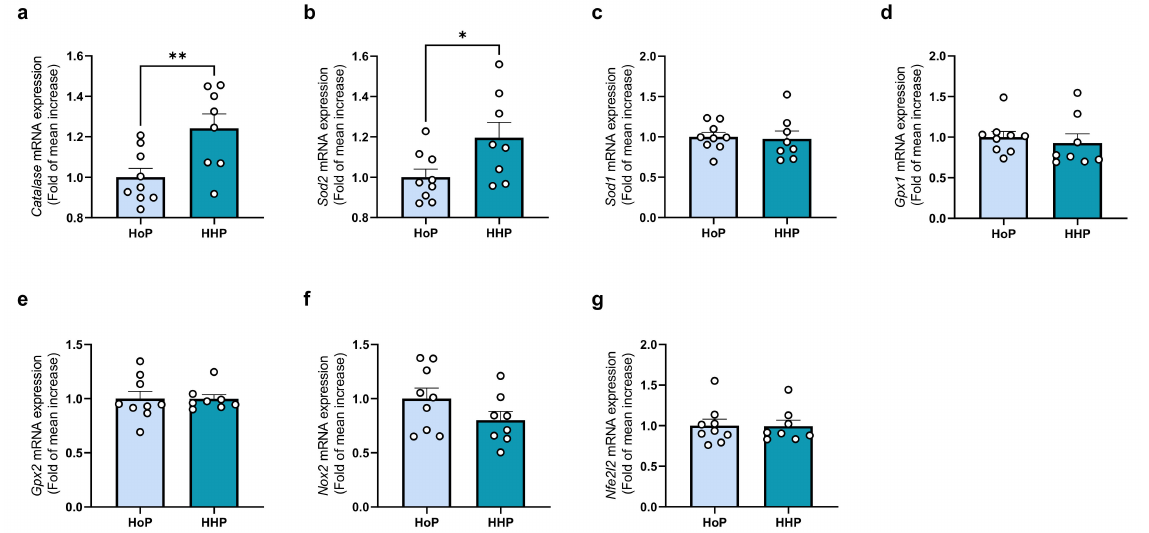
Figure 3. Gene expression levels of antioxidant systems in the liver of mice following a 7 days gavage with HoP- or HHP-DM. ( a ) Catalase (Catalase), ( b ) Sod2 (Superoxide Dismutase 2), ( c ) Sod1 (Superoxide dismutase 1), ( d ) Gpx1 (Glutathion peroxidase 1), ( e ) Gpx2 (Glutathion peroxidase 2), ( f ) Nox1 (NADPH Oxidase 1), ( g ) Nox2 (NADPH Oxidase 2). n = 9 in each group, * p < 0.05, ** p <